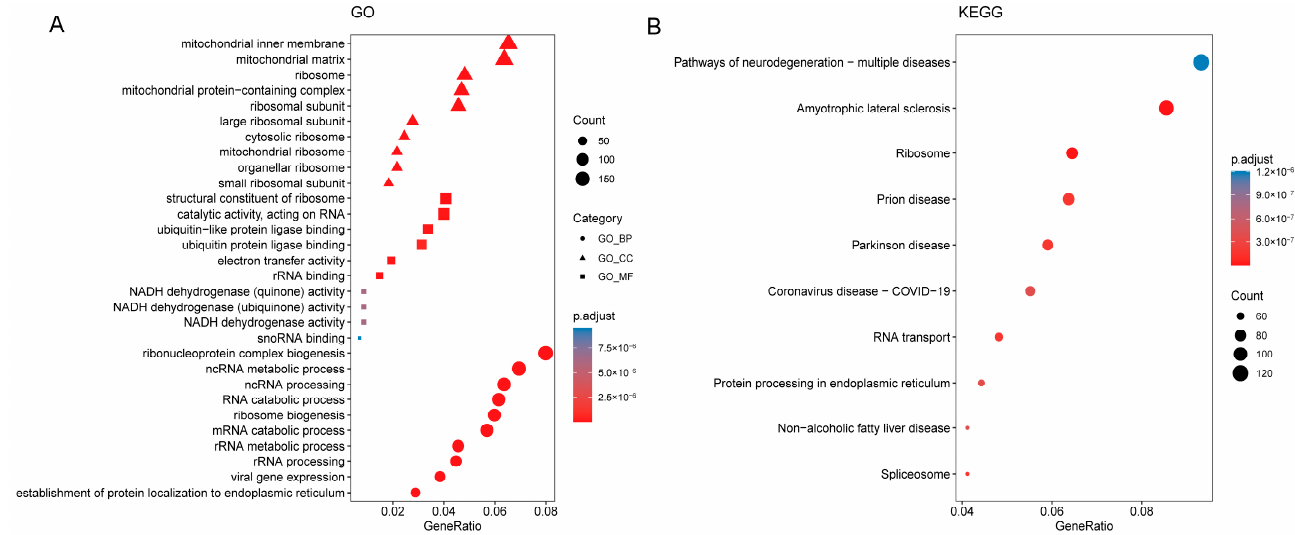
Figure 5. Enrichment analysis of the differentially expressed genes between the two clusters, con- ducted using Gene Ontology (GO) and Kyoto Encyclopedia of Genes and Genomes (KEGG). ( A ) The top 10 enriched GO terms in cellular components, molecular functions, and biological processes, respectively. ( B ) The top 10 enriched KEGG pathways. The warmer color represents a higher statis- tical significance.